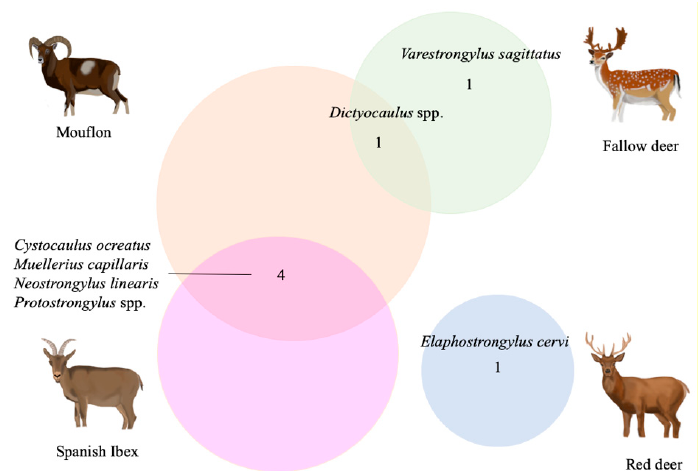
Figure 2. Venn diagram representing the number of lungworm species found in each species of wild ruminant host.